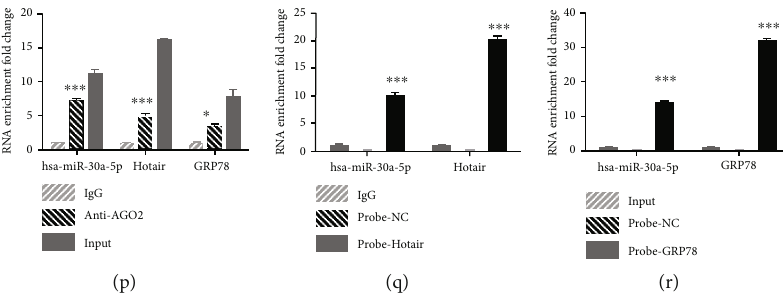
Figure 2: Hotair functions as a sponge for hsa-miR-30a-5p to increase GRP78 expression. The relative RNA expression of GRP78 and hsa-miR- 30a-5p in (a) Tu212 and (b) Hep-2 cells 48h after Hotair overexpression and knockdown as detected by qRT-PCR. The relative RNA expression of GRP78 and Hotair in (c) Tu212 and (d) Hep-2 cells 48h after hsa-miR-30a-5p overexpression and knockdown as detected by qRT-PCR. Western blot analysis of GRP78 after Hotair (e) overexpression or (g) knockdown in Tu212 and Hep-2 cells. The relative expression level of GRP78 (f, h). Western blot analysis of GRP78 after hsa-miR-30a-5p (i) overexpression or (k) knockdown in Tu212 and Hep-2 cells. The relative expression level of GRP78 (j, l). (m) The luciferase reporter assay in Hep-2 cotransfected with control mi-NC or hsa-miR-30a-5p and wild-type or mutant target fragment of hsa-miR-30a-5p in GRP78 luciferase vector. The diagram showed the speci fi c binding site between has-miR-30a-5p and GRP78-3 ′ -UTR. (n) The luciferase reporter assay in Hep-2 cotransfected with control mi-NC or has-miR-30a-5p and wild-type or mutant target fragment of hsa-miR-30a-5p in Hotair luciferase vector. The diagram showed the speci fi c binding site between Hotair and hsa-miR-30a-5p. (o) The luciferase reporter assay in Hep-2 cotransfected with control mi-NC or has-miR-30a-5p, vehicle or Hotair, and wild-type or mutant target fragment of hsa-miR-30a-5p in GRP78 luciferase vector. (p) RIP assay in Hep-2 cells using normal mouse IgG or human anti-Ago2 antibody, followed by qRT-PCR analysis for has-miR-30a-5p, Hotair, and GRP78 expression. (q) RNA pull- down assay in Hep-2 cells using control or Hotair probe, followed by qRT-PCR analysis for has-miR-30a-5p and Hotair expression. (r) RNA pull-down assay in Hep-2 cells using control or GRP78 probe, followed by qRT-PCR analysis for has-miR-30a-5p and GRP78 expression. Data are mean ± SD of at least three independent experiments; ∗ p < 0 : 05 ; ∗∗ p < 0 : 01 ; ∗∗∗ p < 0 : 001 Using the online bioinformatics tool DIANA TOOLS